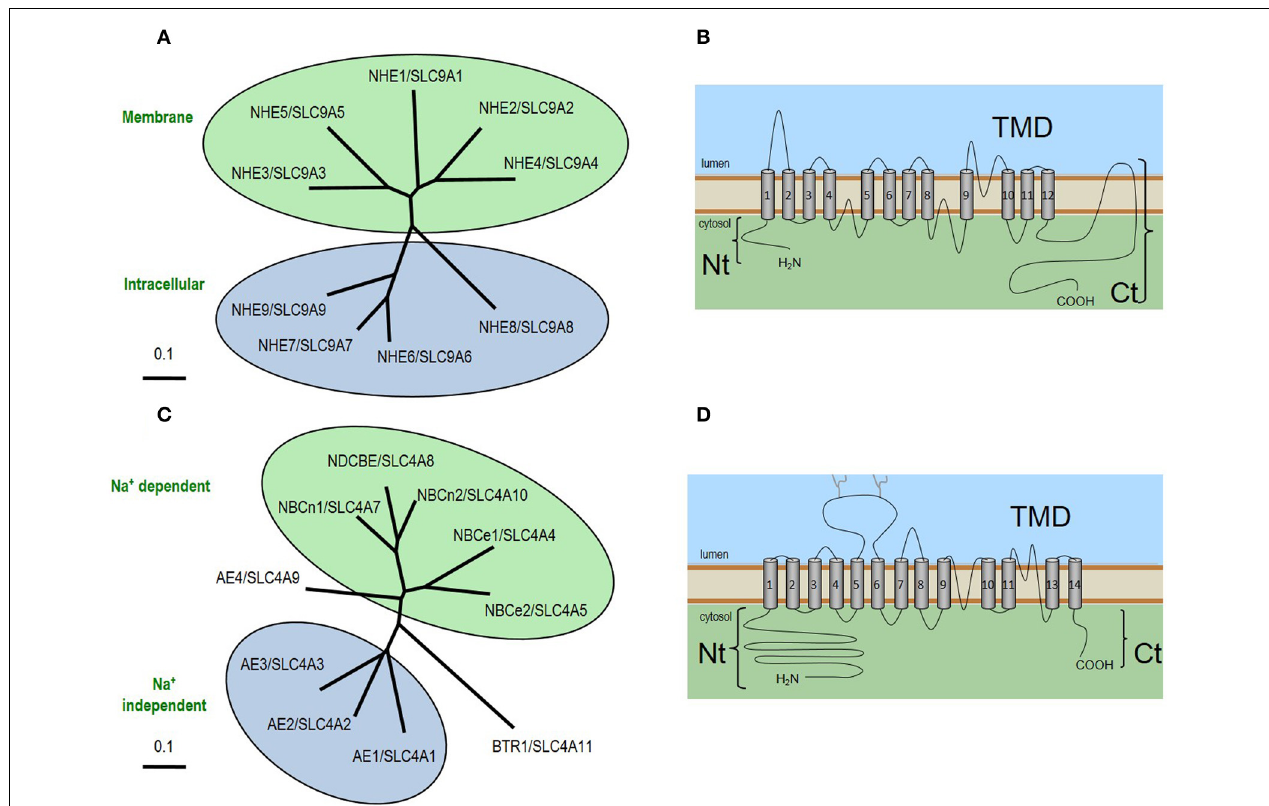
isoform, that is involved in the regulation of exchange activity. (C) The relatedness of SLC4 family proteins. (D) The general topology of SLC4 proteins. The extended N-terminus and C-terminus are linked via a TMD that includes 14 transmembrane spans, one of which (transmembrane span 12) is believed to be an extended non-helical region. Each NCBT gene encodes multiple products that differ from each other in their extreme Nt or Ct sequence (Boron et al.,